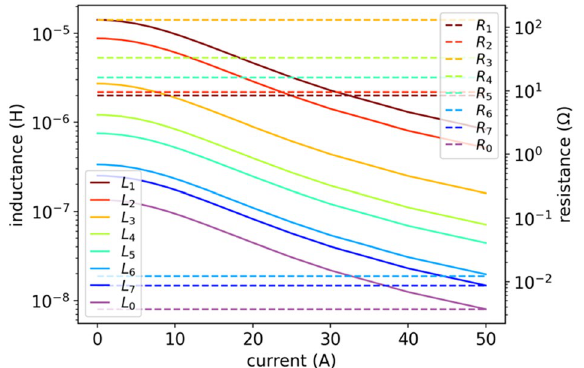
Figure 6. NLS with Langevin constraint results of inductances L ( i ) given by (5) and constant resistances R ( i ) in model (6). Langevin-derivative-like inductances and constant resistances are applied.